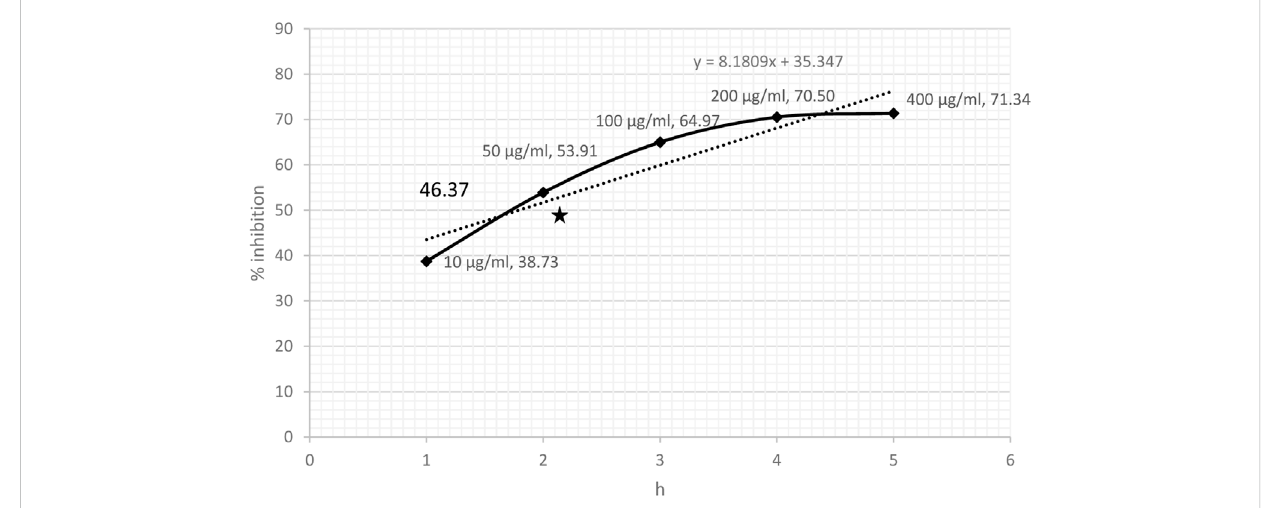
FIGURE 2 DPPH-scavenging effect against various concentrations of C. borivilianum root extract (CRE). IC 50 was estimated based on the graph of respective doses.